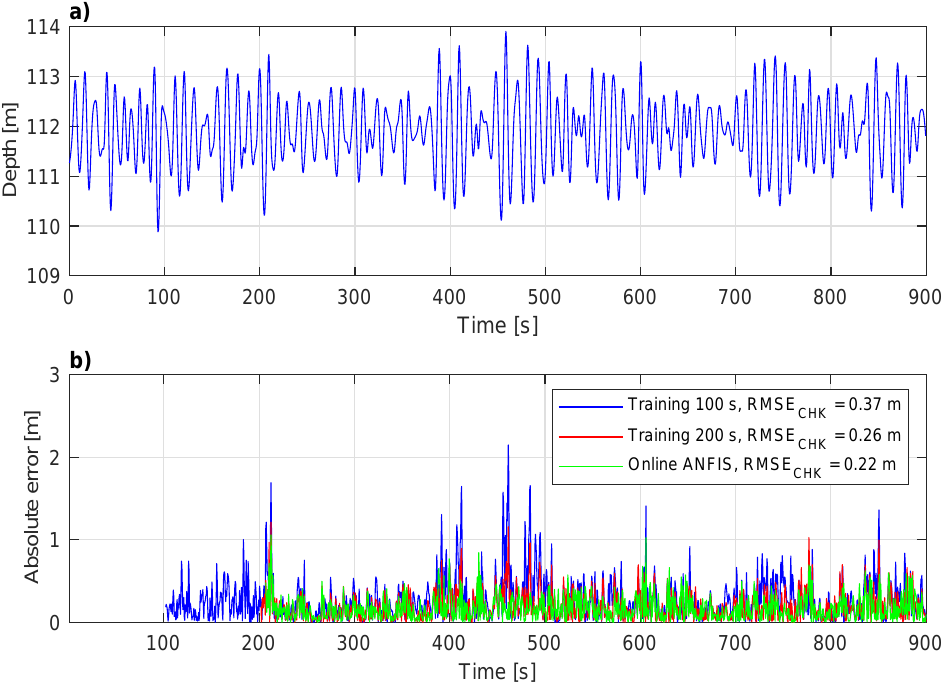
Figure 9. Online trained ANFIS performance. ( a ) The TMS depth dataset used for ANFIS training and evaluation; ( b ) Comparison between ANFIS trained on first 100 s of data (blue), trained on first 200 s of data (red), and trained online using last 200 s of data before each prediction step